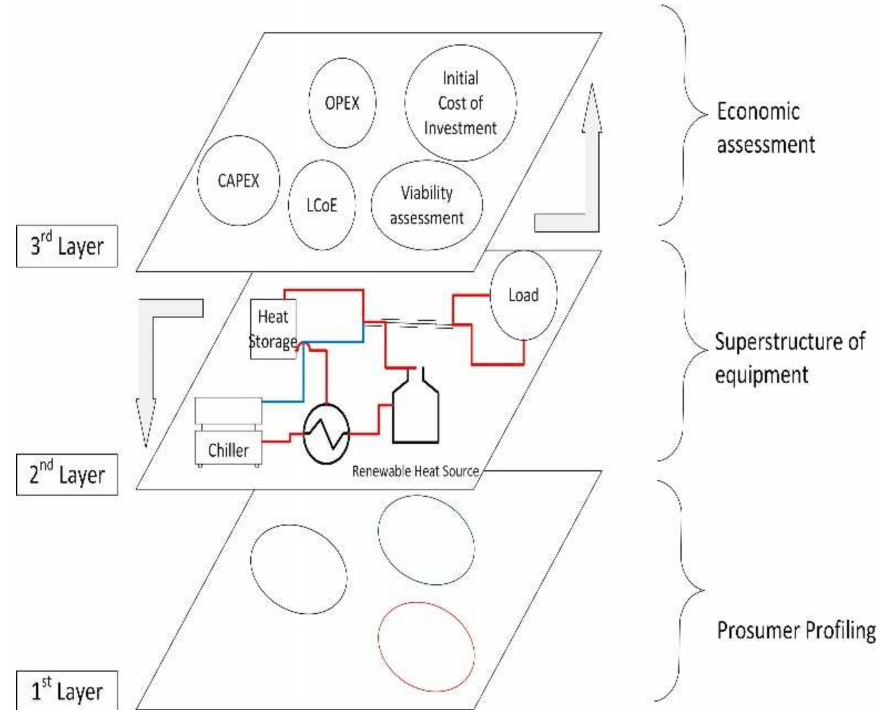
Figure 6. The HDLM complete layer approach taking into account the thermal loads of the prosumers (first layer), the most case-appropriate technologies to be implemented (second layer) and the economic assessment (third layer) of the proposed scenario (to be